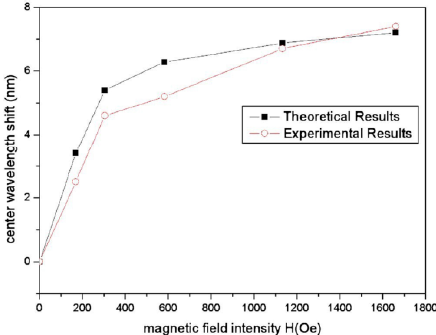
Figure 10. Theoretical and experimental center wavelength shift dependence with the magnetic field. Reproduced from [29], with the permission of AIP